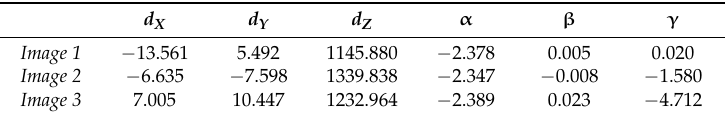
Table 4. Camera extrinsic parameters ( d x , d y , and d z in mm, and α , β , and γ in radians) after joint bundle of epipolar net scene at Figure 9b.